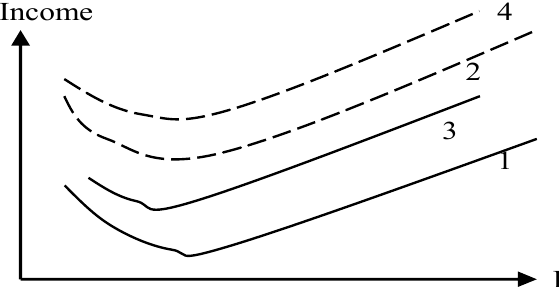
Figure 7. The ratio of income and risk when expanding the resource and changing the number of portfolio units, while maintaining the profitability of units in the portfolio (income maximization model).